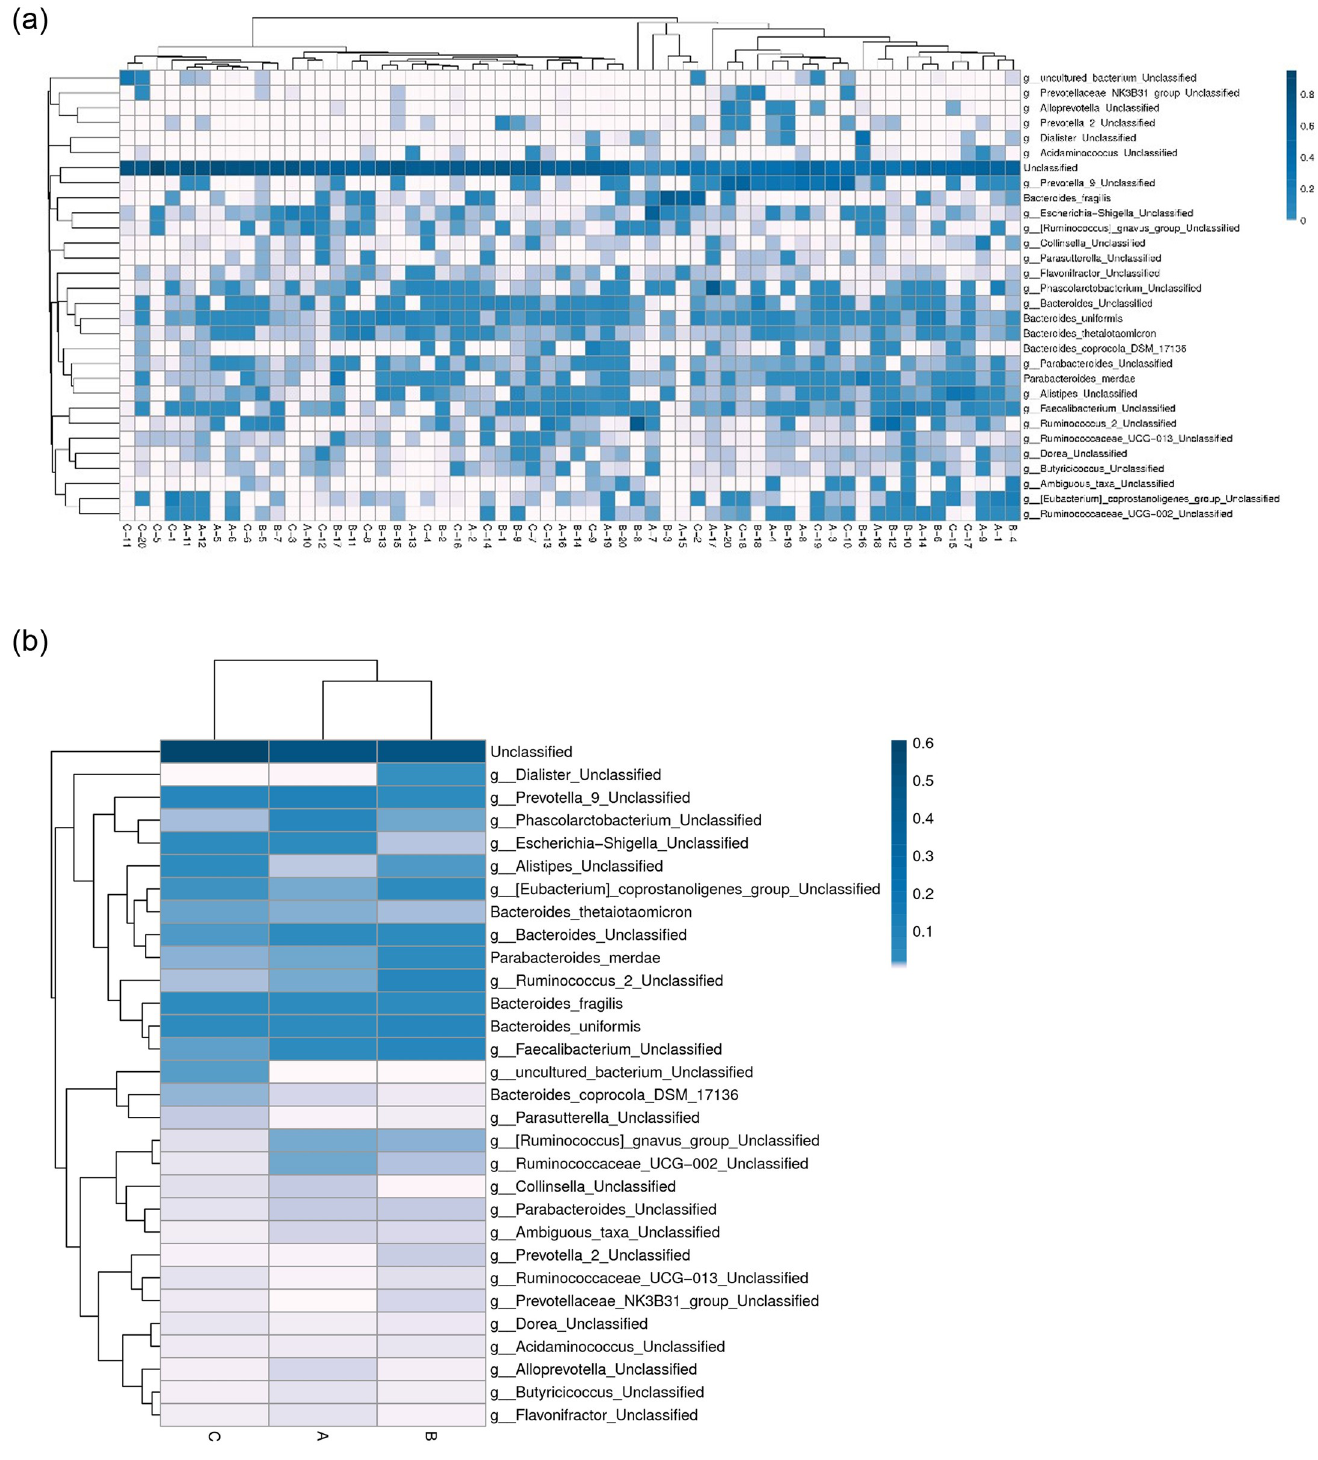
Fig 3. The heatmap analysis of the top 30 species. a: Cluster of samples. b: Cluster of groups. The columns represent samples and/or groups and the rows represent species. The dendrogram above the heatmap is the cluster result of the samples and/or groups and the dendrogram to the left is the species cluster. The colours in the heat map represent the relative abundance of the corresponding species in the corresponding sample or group.